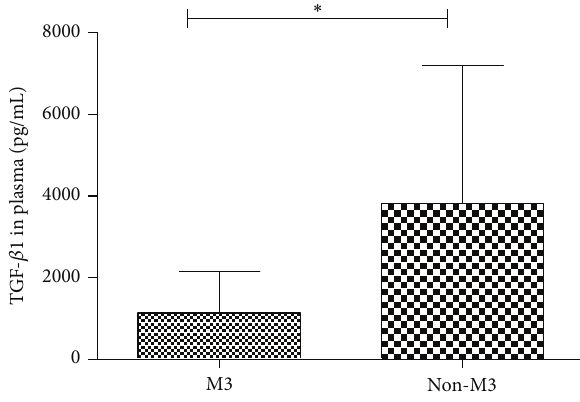
Figure 7: BM plasma TGF- 𝛽 1 level among different FAB subtypes of AML. A significant decrease of BM plasma TGF- 𝛽 1 level in M3 patients compared with the other subtypes ( ∗ 𝑃 = 0.0005